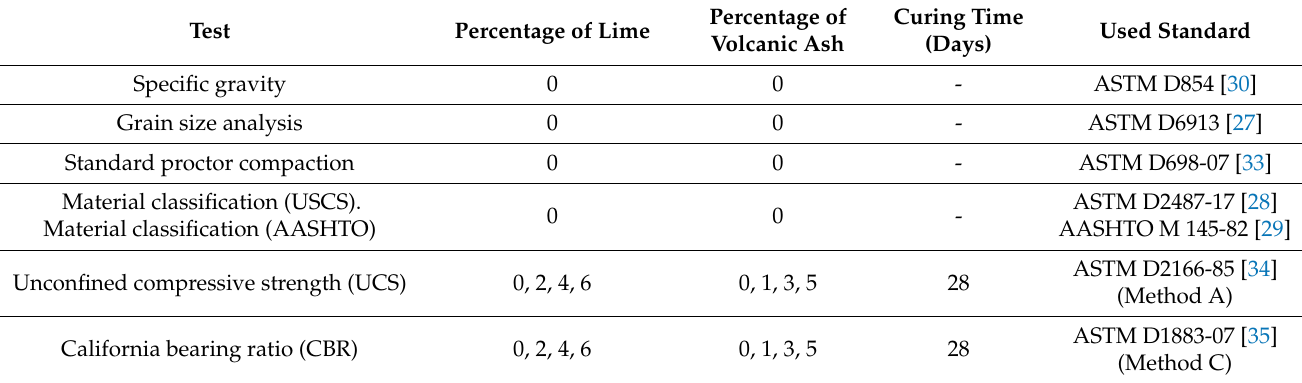
Table 3. Physical and engineering testing program of the treated dune